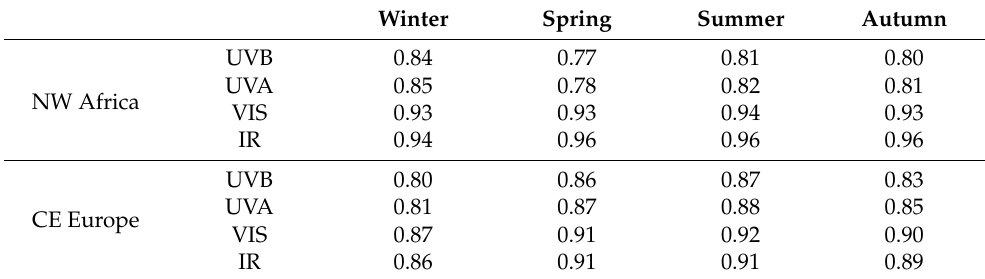
Table 3. SSA used in the simulations for NW Africa and CE Europe. For each spectral band, independence from wavelength SSA was assumed.